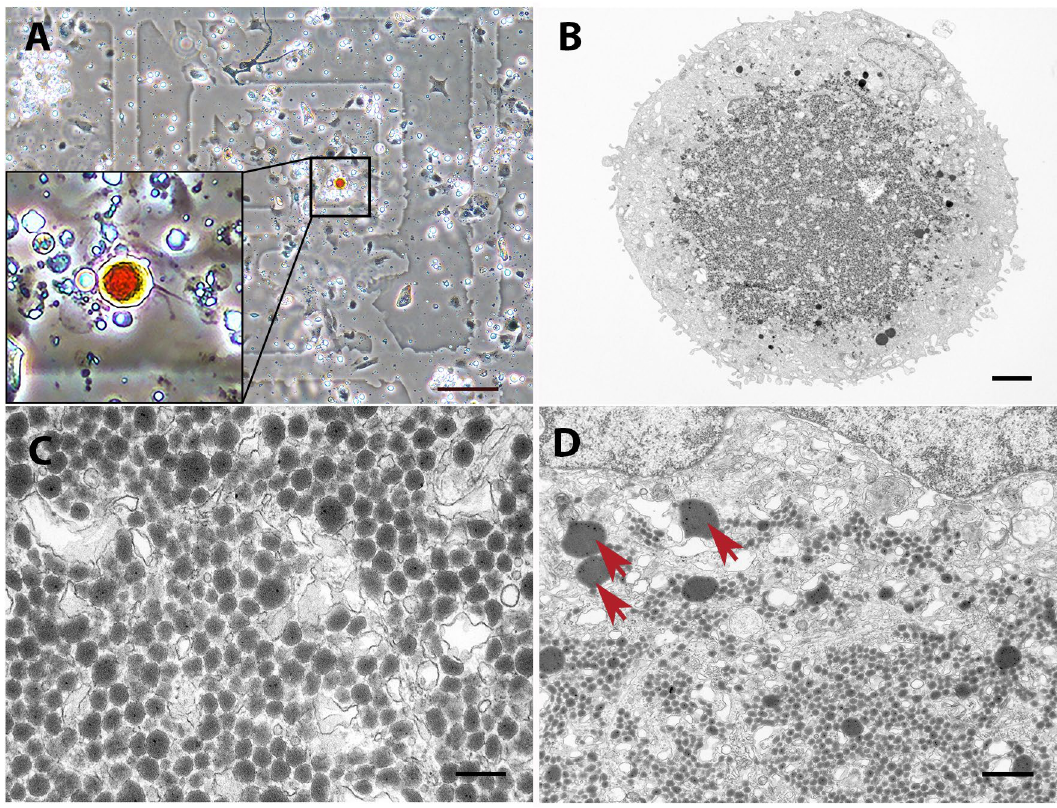
Figure 3. CLEM of a type 1 erythrophore from black spot. ( A ) An isolated type 1 erythrophore on a MatTek dish, observed with phase-contrast microscopy. ( B – D ) Ultrastructure of the same cell, observed with TEM. Carotenoid vesicles (red arrowheads), singular erythrosome-like larger inclusions (red arrows). Scale bars: 100 μm ( A ); 2 μm ( B ); 200 nm ( C ); 600 nm ( D A STRING 10 analysis was also done on the same 16 candidate genes to determine protein interactions. Puta- tive homologues of these genes in D. rerio were analysed, except for claudin-24 , which is not present in the D. rerio genome. The enriched KEGG pathway in the network was melanogenesis, and transmembrane signalling receptor activity as a molecular function. Multiple interactions, including co-expression, are evident among these genes (Fig. 6). Paralogue gene analyses. Blast hits of analysed transcripts and their locations are reported together with paralogue gene information (Table 1). Except for bicc2 and tmem130 , which do not have paralogues in the brown trout genome, all the other analysed genes have two, three, or even four paralogues in the brown trout genome, stemming from either salmonid-specific fourth vertebrate whole-genome duplication (Ss4R) or both Ss4R and fish-specific genome duplication (FSGD) events (Table 1). Primer blast for most of the analysed loci revealed that transcripts from only one paralogue were quantified with qPCR (original primers perfectly matched both paralogues only for the gene nptx1 ). Three genes were selected for more in-depth analyses: mitfa , sox10, and pax7a . Two copies of the mitf gene are known in zebrafish, mitfa and mitfb , as a result of FSGD. The Ss4R promoted the presence of four paralogues of mitf in the brown trout genome ( mitfa on chromosomes 14 and 16 and mitfb on chromosomes 28 and 30; Table 1). Closer analyses of the transcriptome data and transcript blasting of the brown trout genome revealed that transcripts from all four paralogues are expressed in brown trout skin. The paralogue on chromosome 14 was predominantly expressed in red spots, while its expression in other skin regions was considerably lower. The original primers designed for qPCR specifically aligned to this paralogue, and thus only the expression of mitfa coded on chromosome 14 was detected with qPCR, which revealed its upregulated expression in red spots compared with other skin regions. To determine the expression profiles of paralogue gene copies in differently pigmented skin regions, paralogue-specific primers were designed for the remaining three paralogues of mitf (positioned on chromosomes 16 ( mitfa ), 28, and 30 (both designated as mitf ) (Table 1)). No differences in the expressions of the other three mitf paralogues were detected between differently pigmented skin regions in brown trout. All four mift paralogues code for functional proteins with potentially altered transcription activation (see Supplementary information online for more details). The brown trout genome contains three paralogues of pax7 (two copies of pax7a stemming from Ss4R and pax7b ), whereas most teleost fish have two copies ( pax7a and pax7b as a result of FSGD). Two paralogues of sox10 are also present in the brown trout genome (stemming from Ss4R), whereas no paralogue from FSGD